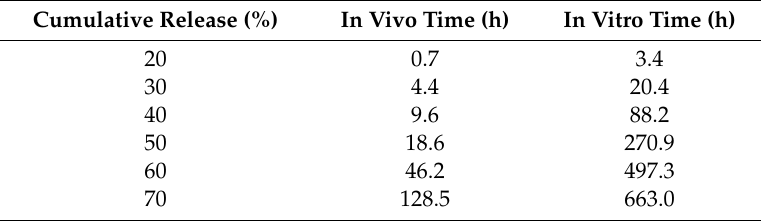
Figure 5. In vitro–in vivo correlation. ( A ) Observed in vitro release profile and predicted in vivo release profile of Lucrin depot ® . Closed circles mean the observed in vitro release profile. Solid line indicates the predicted in vivo release profile. ( B ) The correlation between times representing the same percent of cumulative release in vitro and in vivo. Table 1. In vivo and in vitro time according to the percentage of cumulative